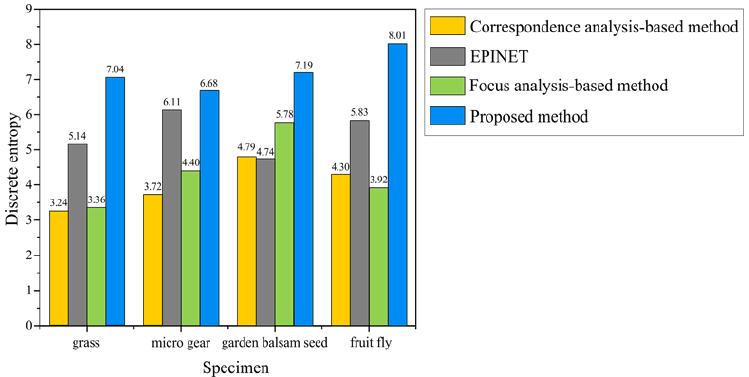
Figure 8. Comparison of the quantitive results of discrete entropy